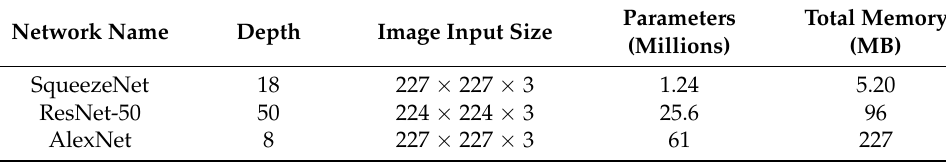
Table 2. Model comparison 1